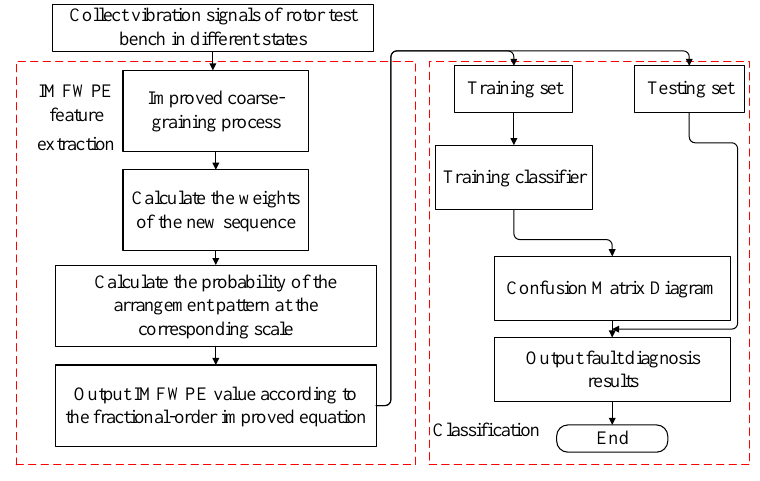
Figure 2. IMFWPE – XGBoost fault diagnosis method flow. Figure 2. IMFWPE–XGBoost fault diagnosis method flow.